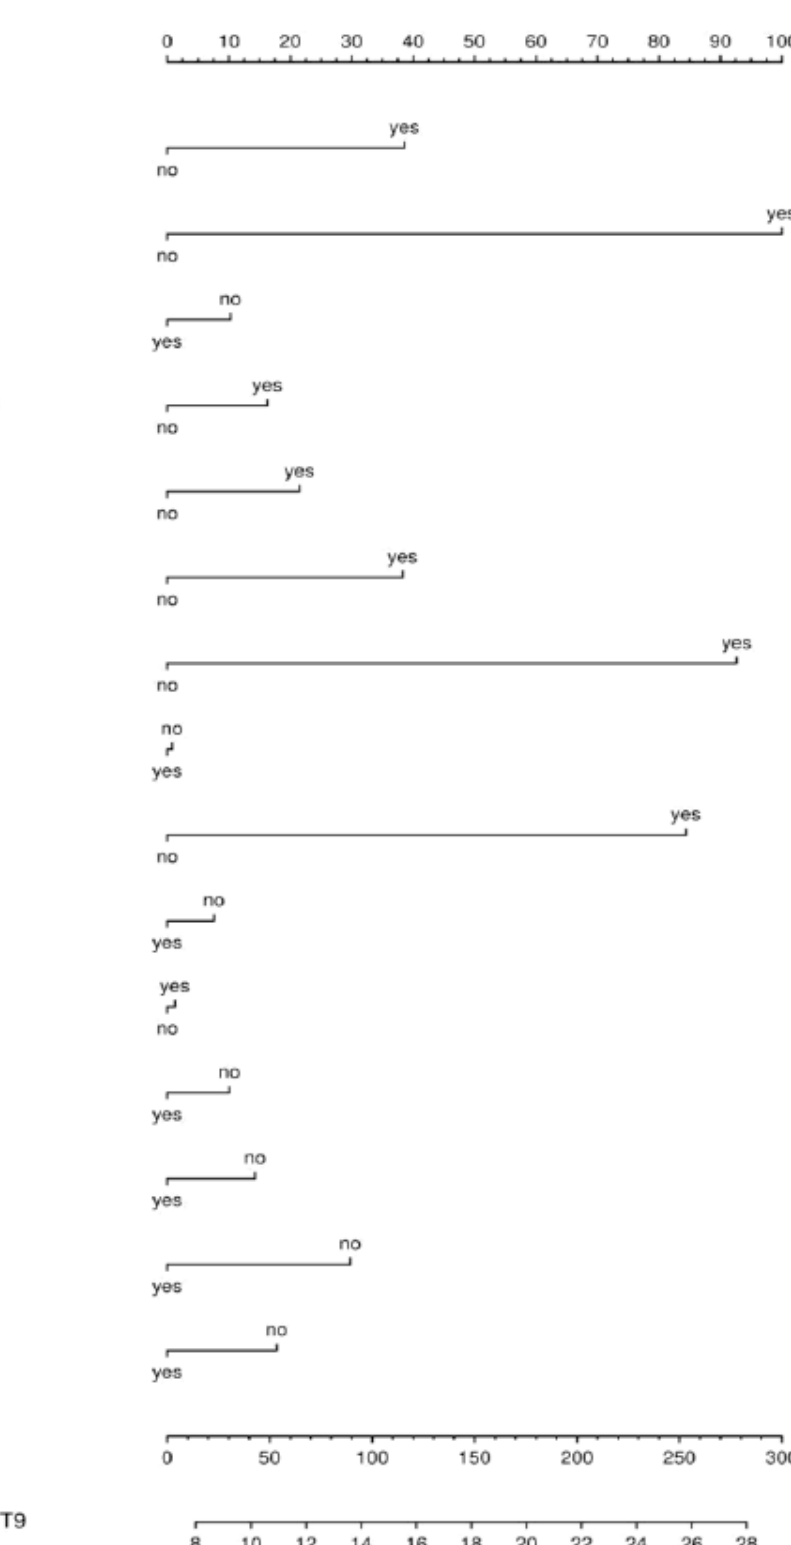
Figure A9. Nomogram IADL disability score at Figure 9. Nomogram IADL disability score at T9. Table 6. Rsq-values and relative importance TFI items for the IADL disability scores.